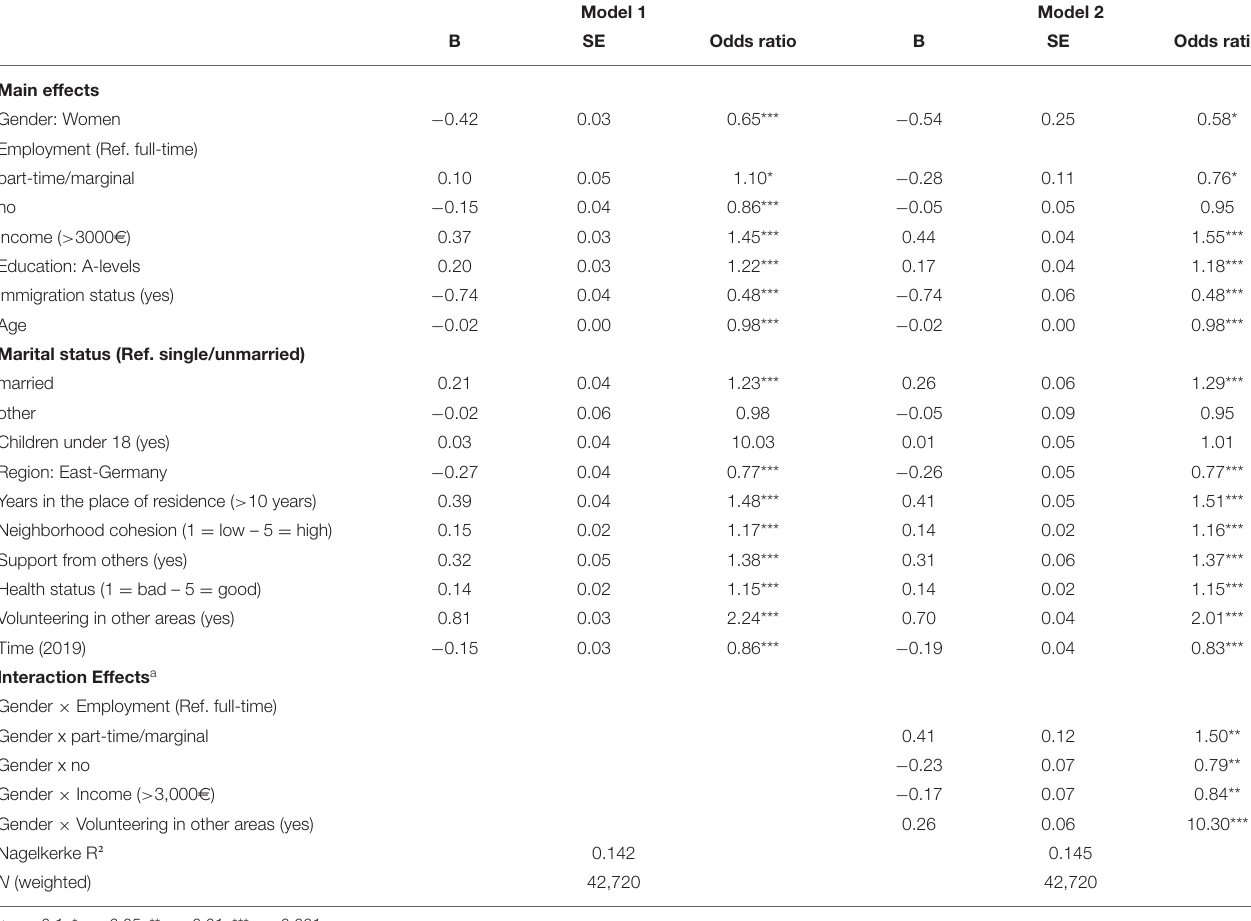
TABLE 6 | Predictors of volunteering in sport in 2014 and 2019.